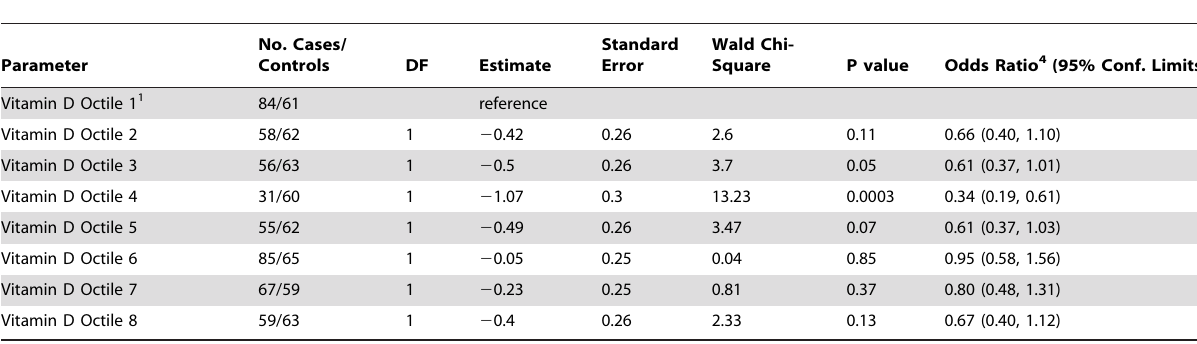
Table 3. Results of the conditional logistic regression analysis not including covariates.